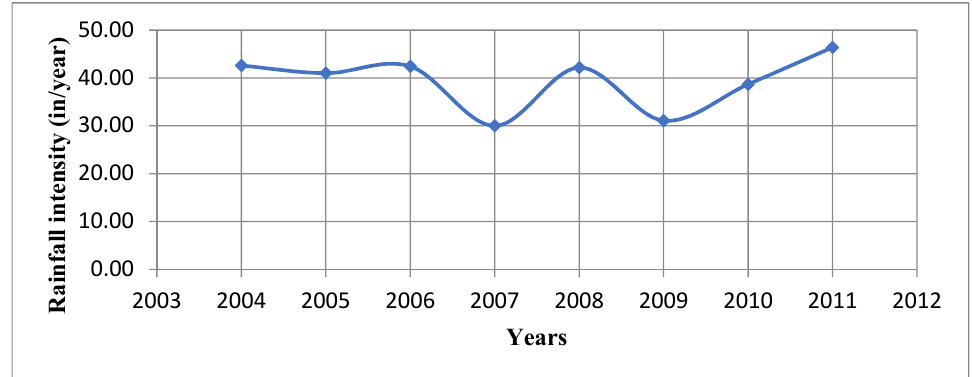
Figure 6. Annual rainfall (2004–2011) in/year.